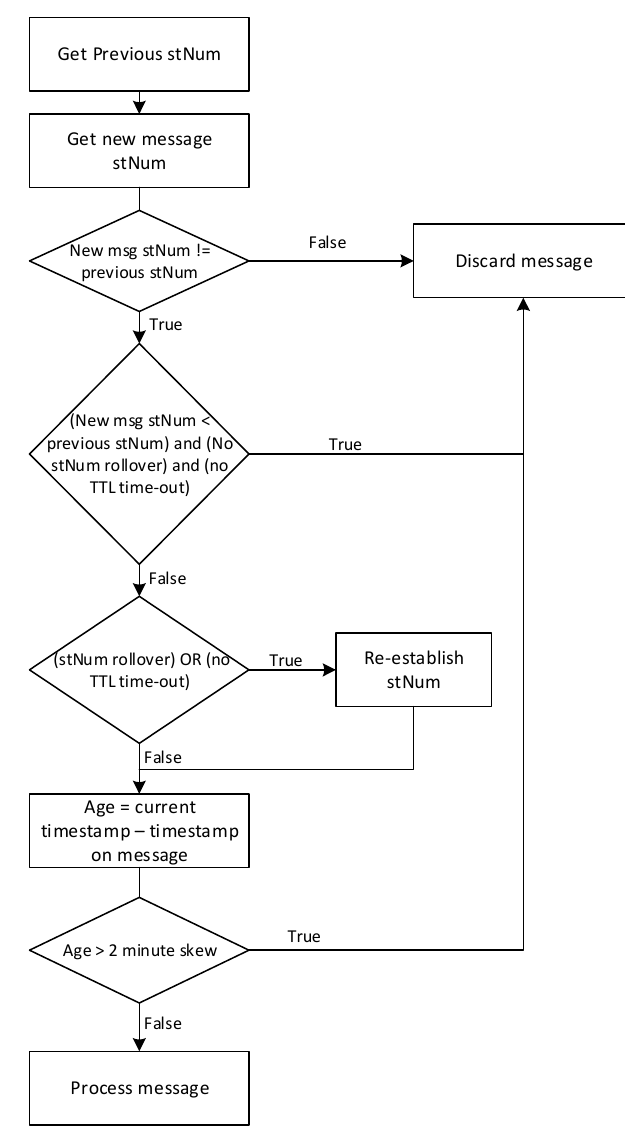
Figure 3. GOOSE Messages Processing Algorithm.